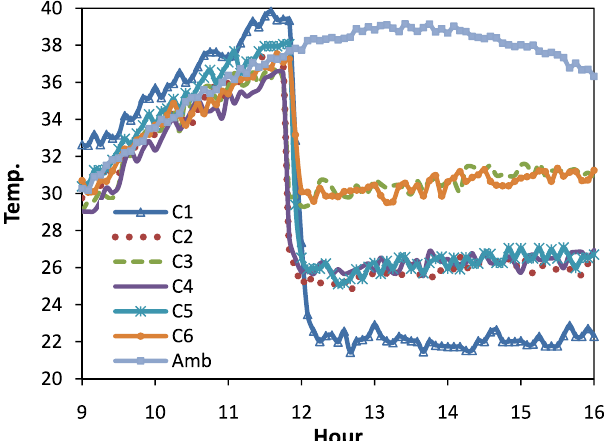
Fig. 2. Comparison of compressors inlet temperature and ambient temperature through one day.